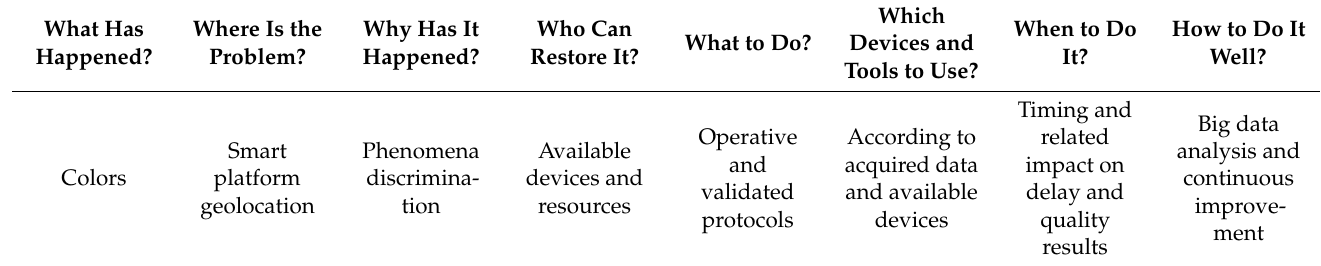
Table 3. Healthcare 4.0—8Ws and related reply for neonatal apnea smart